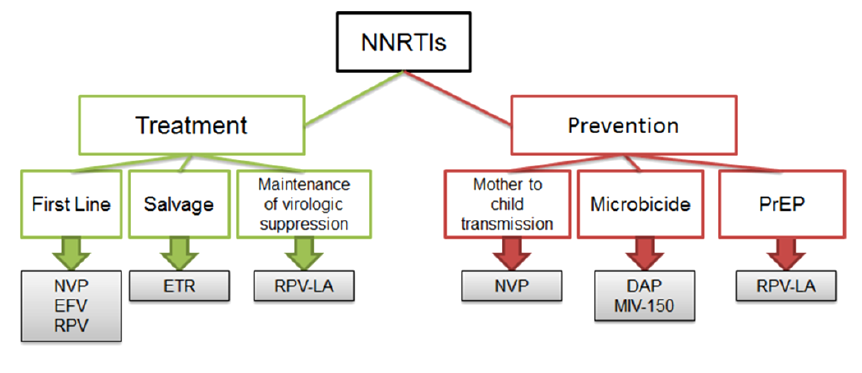
Figure 2. Expanding use of NNRTIs in HIV-1 prevention and treatment